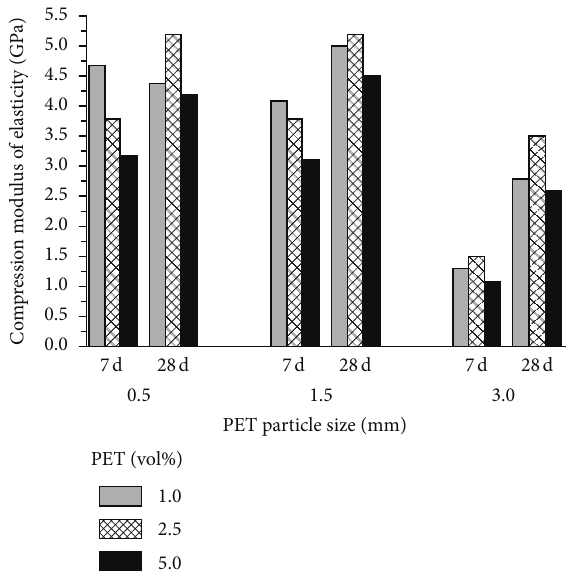
Figure 4: Modulus of elasticity under compression of concrete with recycled PET